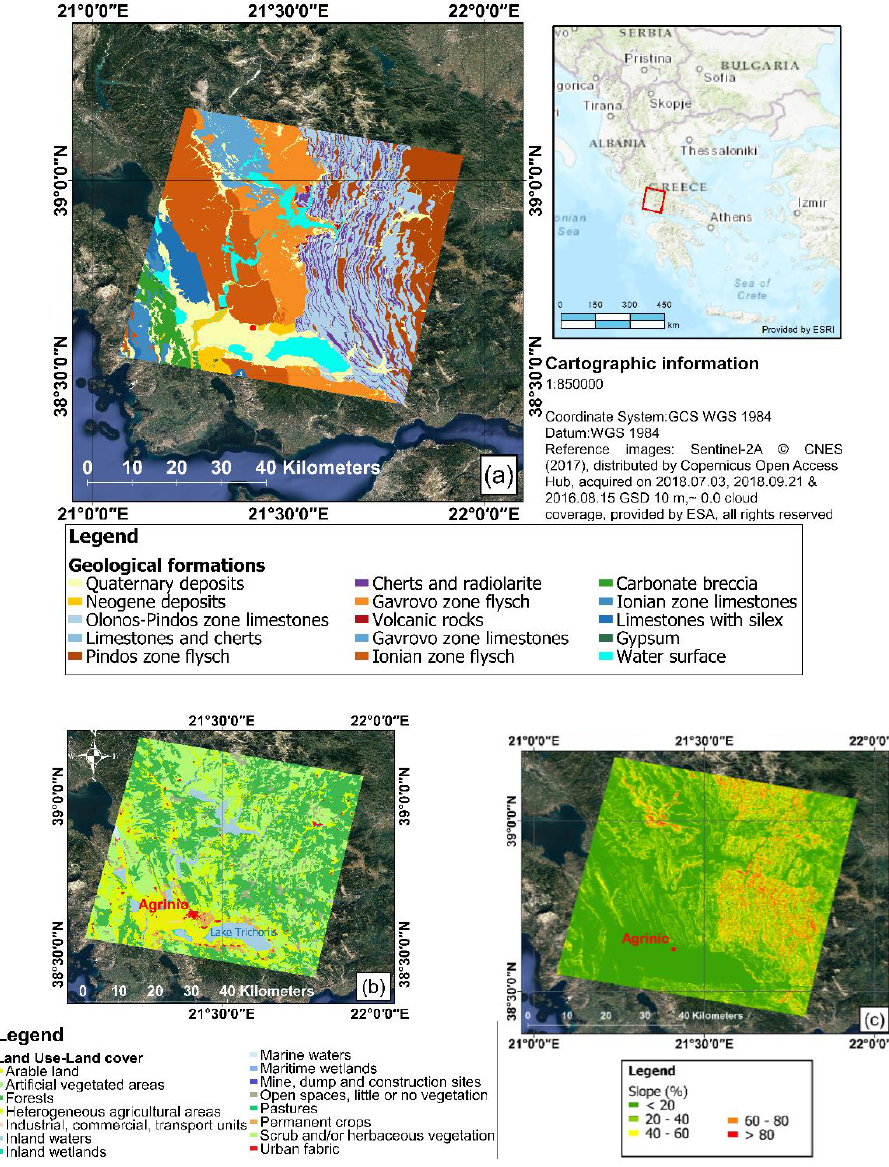
Figure 3. A number of the predisposing factors used for landslide susceptibility analysis ( a ) geological map; ( b ) land use land cover map; ( c ) slope map. The reference image, the coordinate system, and datum information of all maps are provided in map ( a